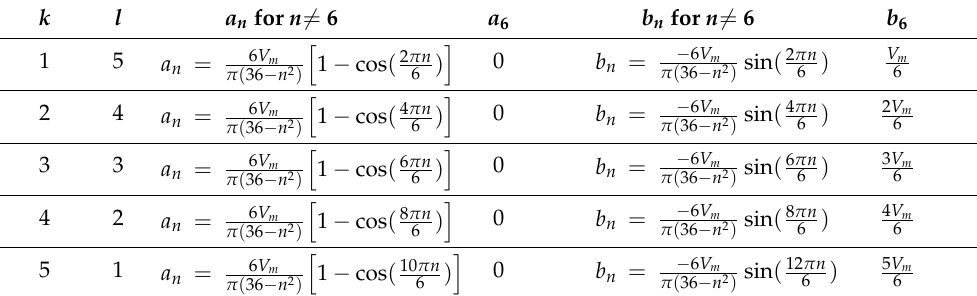
Table 1. Fourier coefficients for various combinations of on-off cycles with pulse selective